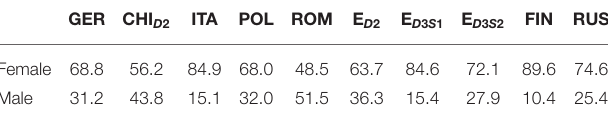
TABLE A4 | Percentage of participants with certain gender.